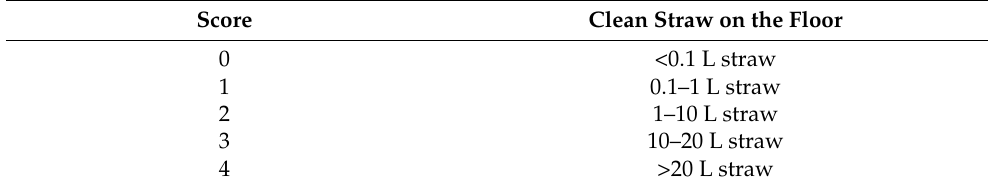
Table 2. Scoring system used to visually assess clean (unsoiled, seemingly fresh) straw on the floor and in straw racks (modified from [22]). For the corresponding amount of straw in the rack, please see